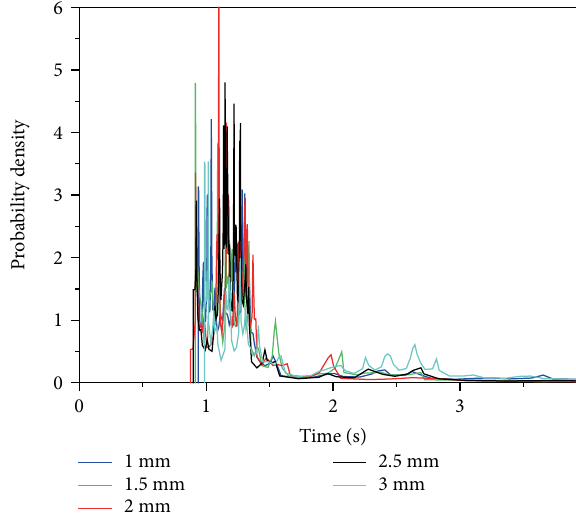
Figure 16: Influence of eccentricity on the maximum shear rate (a) and stretching rate (b).